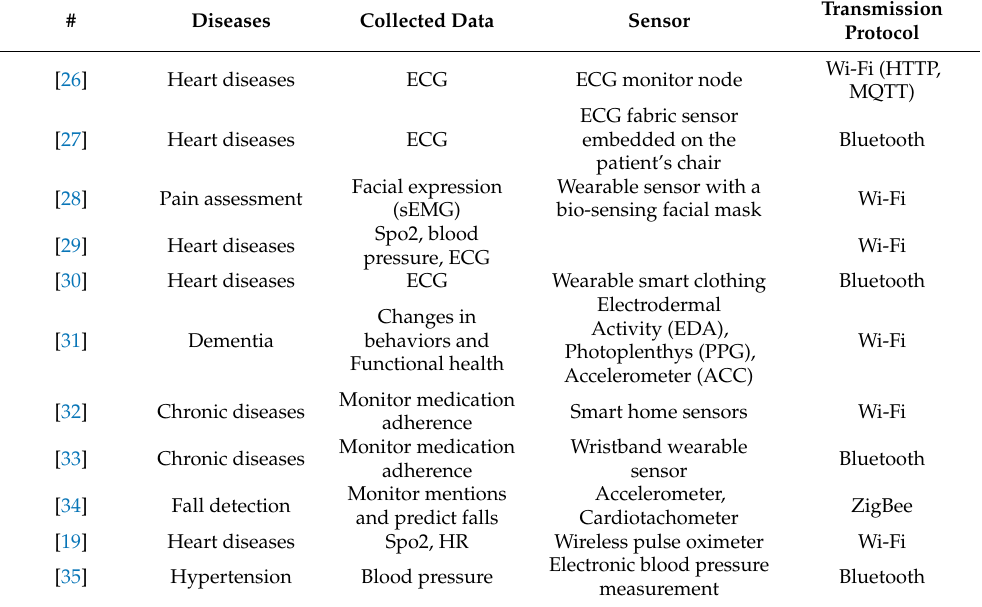
Table 3. Description of selected